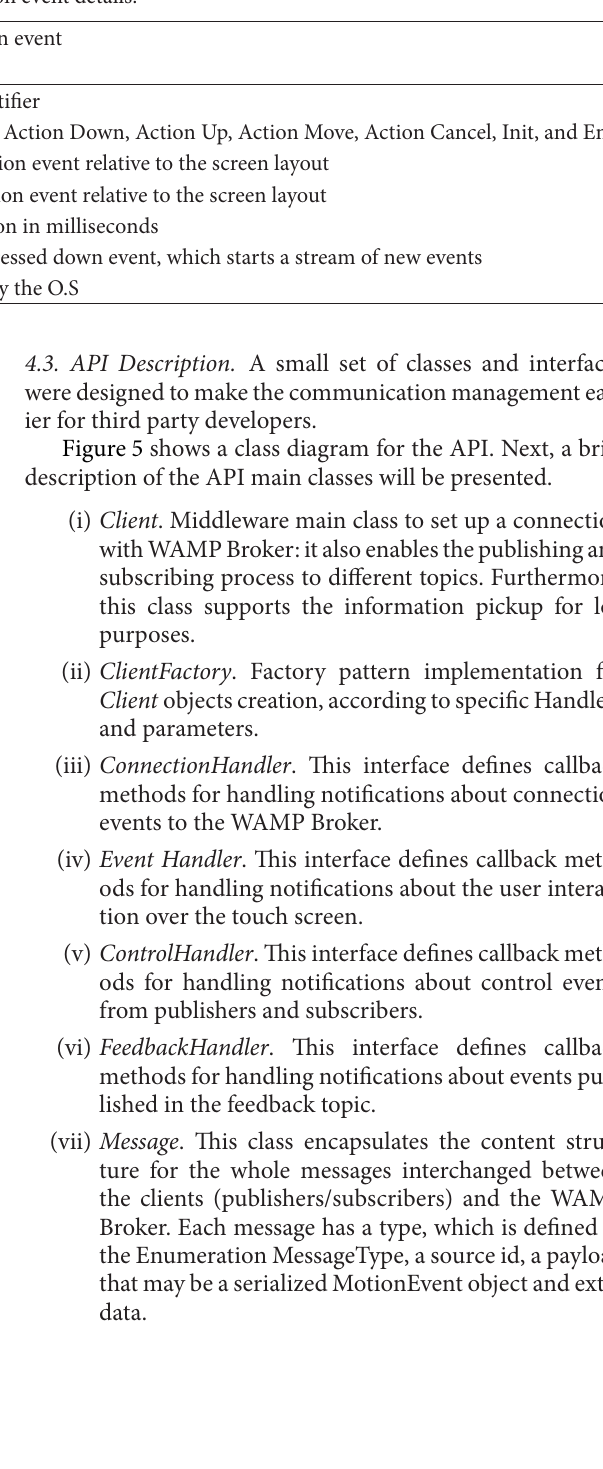
Table 2: Motion event details.